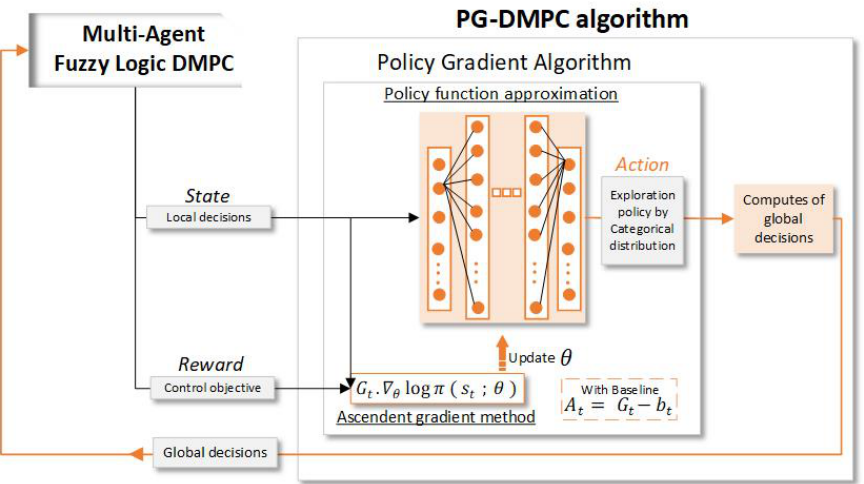
Figure 2. PG optimization scheme for the required negotiation agent in the upper-level control layer in the distributed MPC-based control